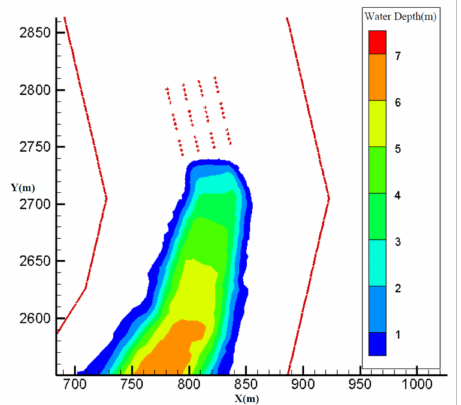
Figure 16. Water level at B1 bridge at time 620 s.